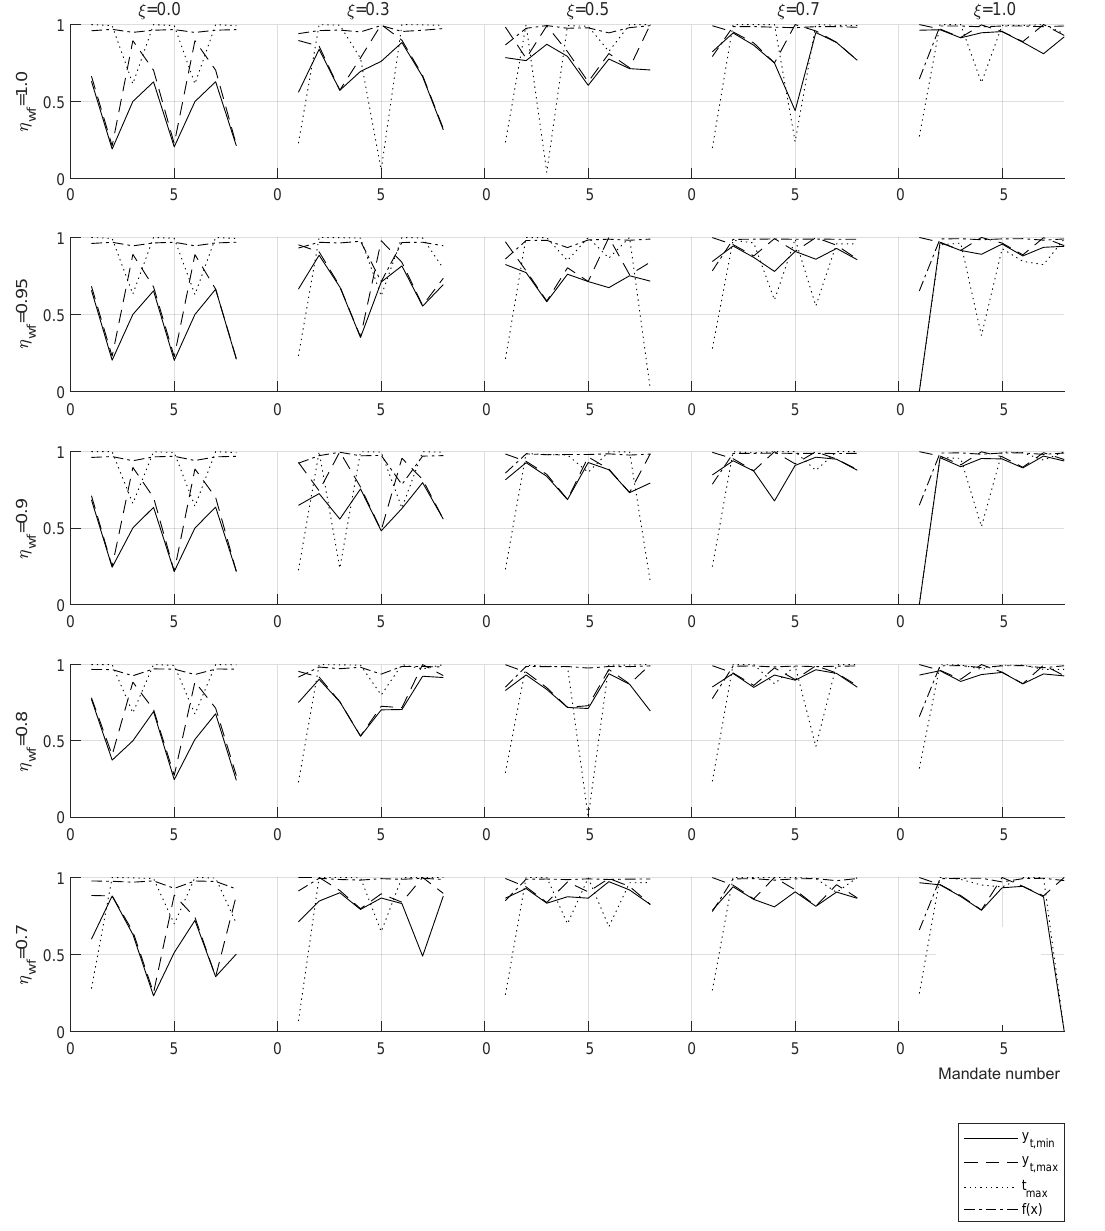
Figure A1. Tax policy evolution under yardstick vote during eight mandates for a series of welfare efficiency values η wf and tax disincentive ξ . Median criterion. Mandate length: 4